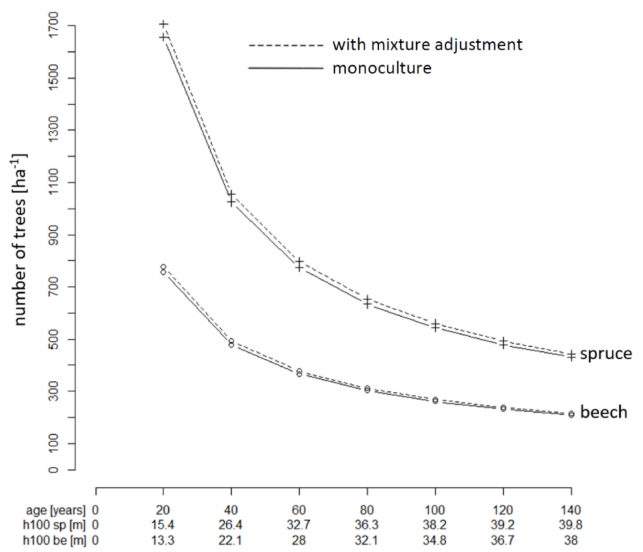
Figure 4. Number of trees at full stocking per ha ( FS ) over stand age ( t ) based on Equation (2), given for Norway spruce ( sp ) and European beech ( be ); given in addition to over top height h 100 . Curves shown with a solid line refer to monospecific stands and therefore assume a mixture adjustment CF of 1.0 in Equation (2) (Section 2.1.2); curves shown with a dotted line assume that crowns overlap according to a mixture adjustment CF of 1.03 in Equation (2) (Section 2.1.2, Table 1). The mean diameter at breast height in Equation (2) was taken according to the stand age (Figure 2); crown projection parameters ( c , d ) from Table 4.